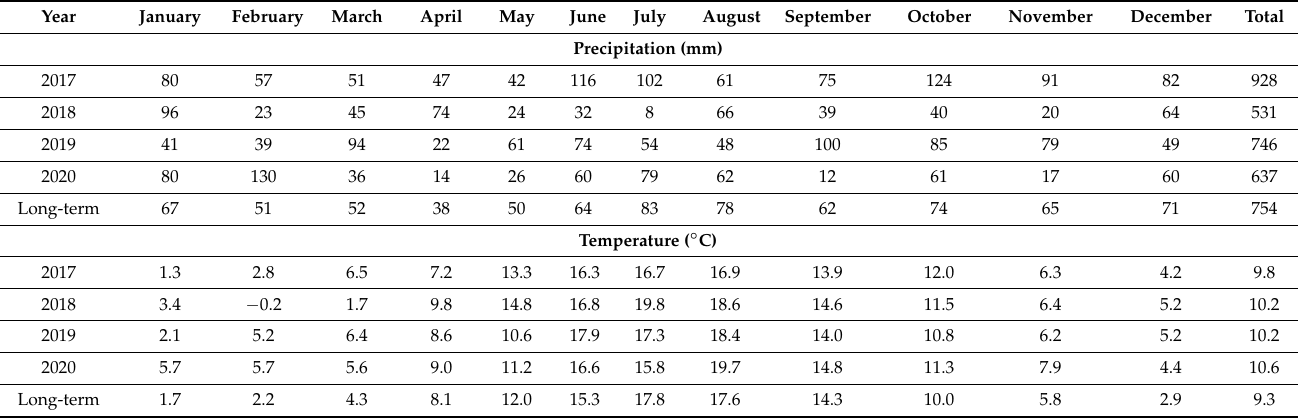
Table 2. Monthly precipitation and average temperatures during the study period compared to the long-term total precipitation and average temperature (1991–2020) [44].